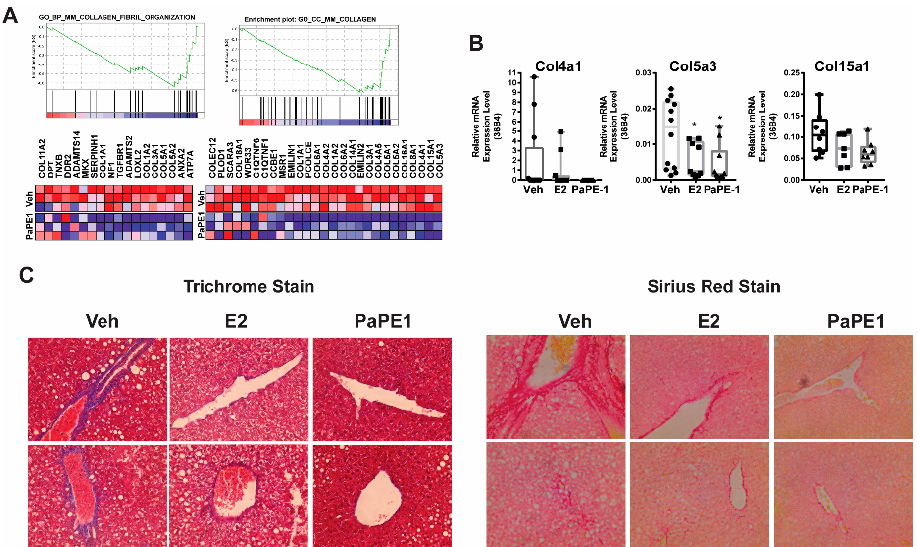
Figure 5. Decreased Collagen deposition in PaPE − 1 treated mice livers ( A ) RNA − Seq analysis showed that PaPE − 1 specifically downregulated collagen target genes. This is relevant to fibrosis, which is a hallmark of the next step after Nonalcoholic fatty liver disease (NAFLD), Nonalcoholic steatohepatitis (NASH). ( B ) PaPE − 1 very effectively downregulated representative mice hepatic collagen genes in mice livers. ( C ) Trichrome and Sirius red staining showed PaPE − 1 was very effective in decreasing mice’s hepatic collagen deposition (Blue in Trichrome stain, red in Sirius Red stain). *, p < 0.05.